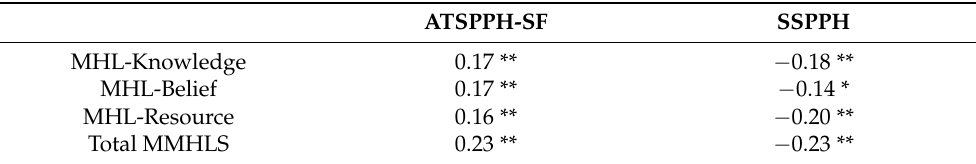
Table 3. Correlation between MMHLS and related variables.